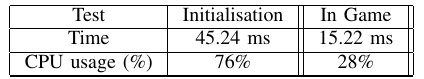
Table II: Numerical results from the game on different